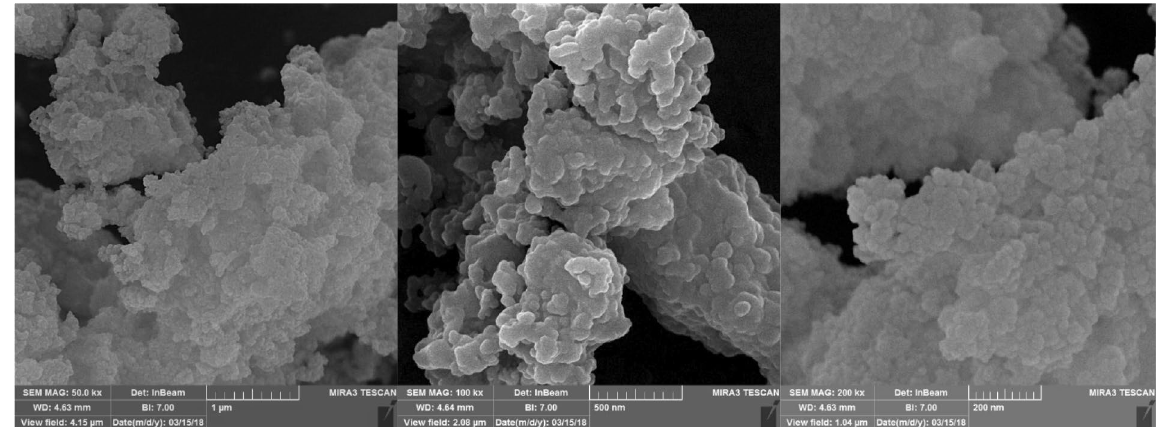
Figure 7. FESEM images of the Iron oxide@PMO-ICS-PrSO 3 H magnetic mesoporous nanocatalyst ( 1 ).